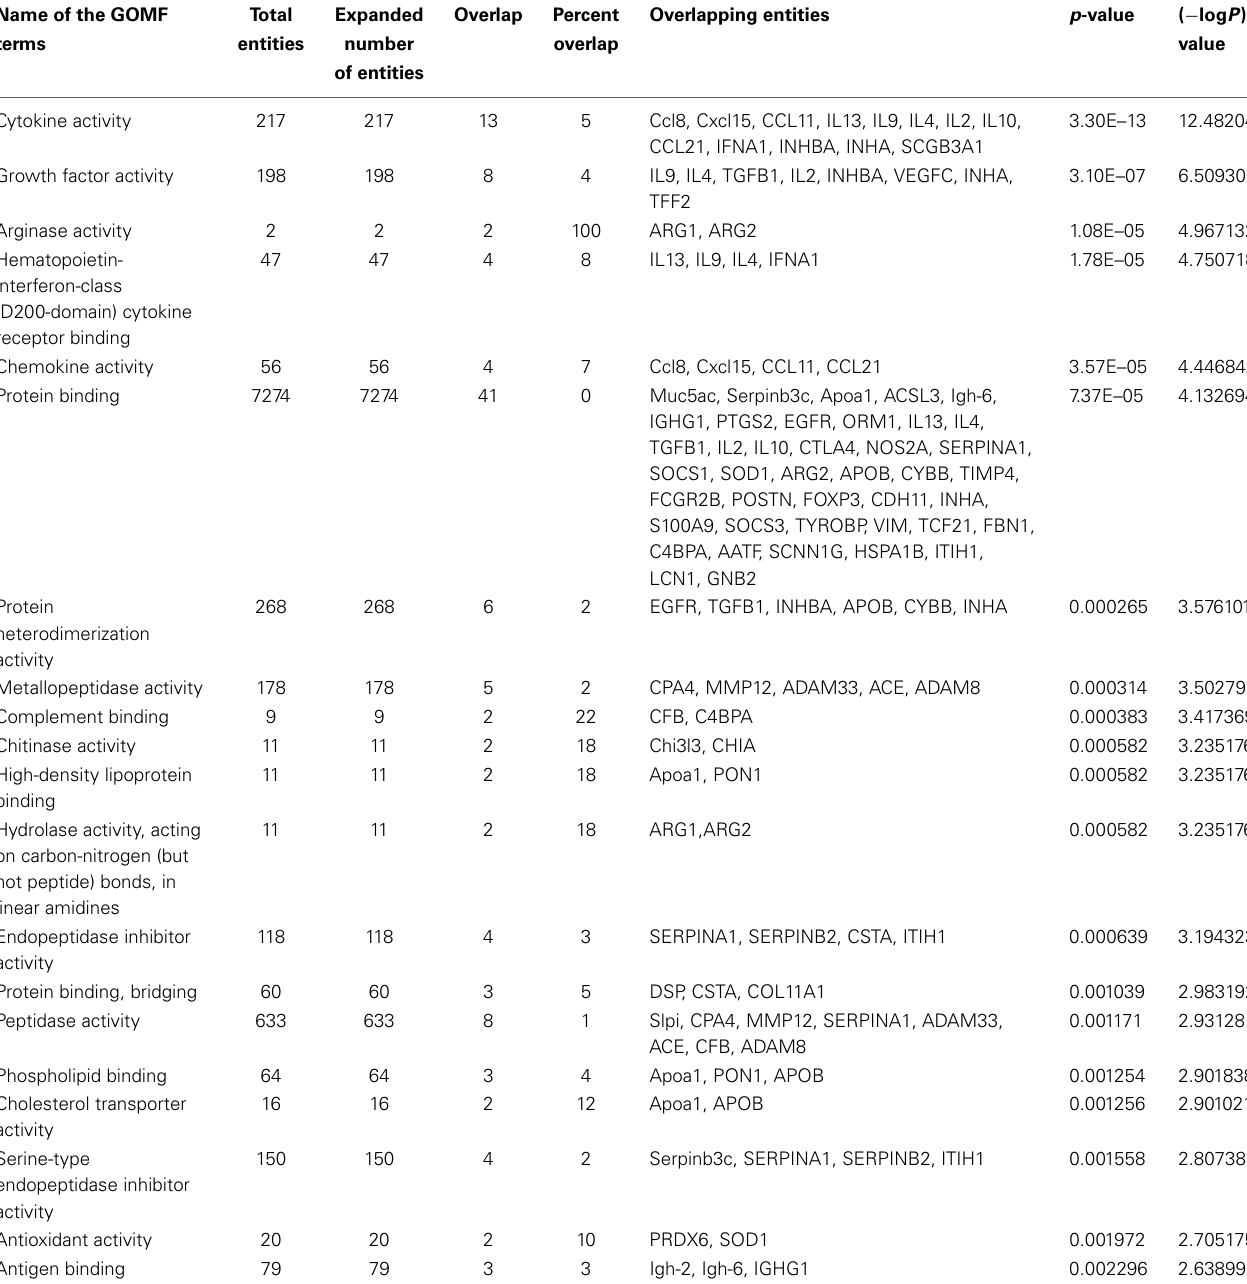
Table A2 | The list of Gene Ontology Molecular Function (GOMF) terms that are significant in asthma pathogenesis, as evident from the biomarkers identified by genomics, proteomics and epigenomics